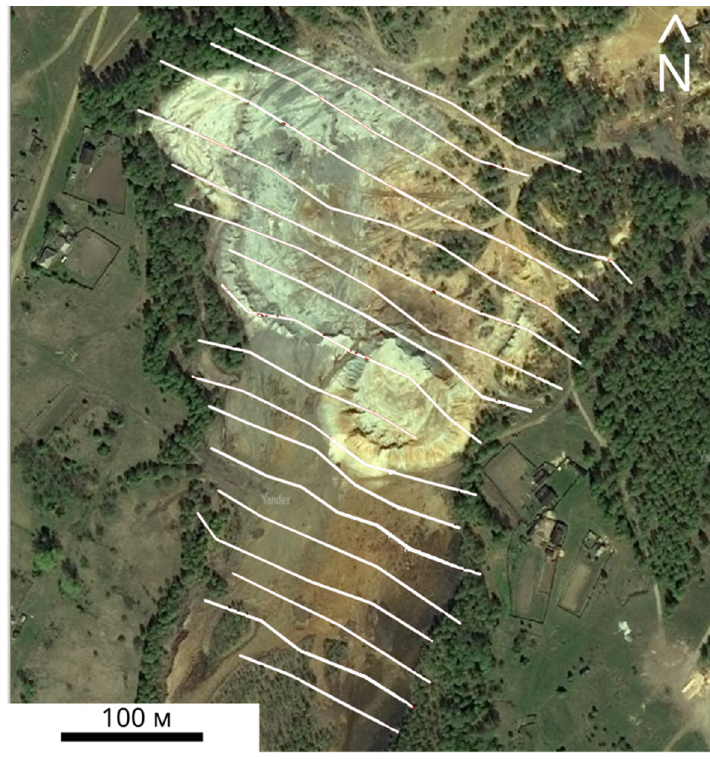
Figure 4. Configuration of profiles for magnetic survey.